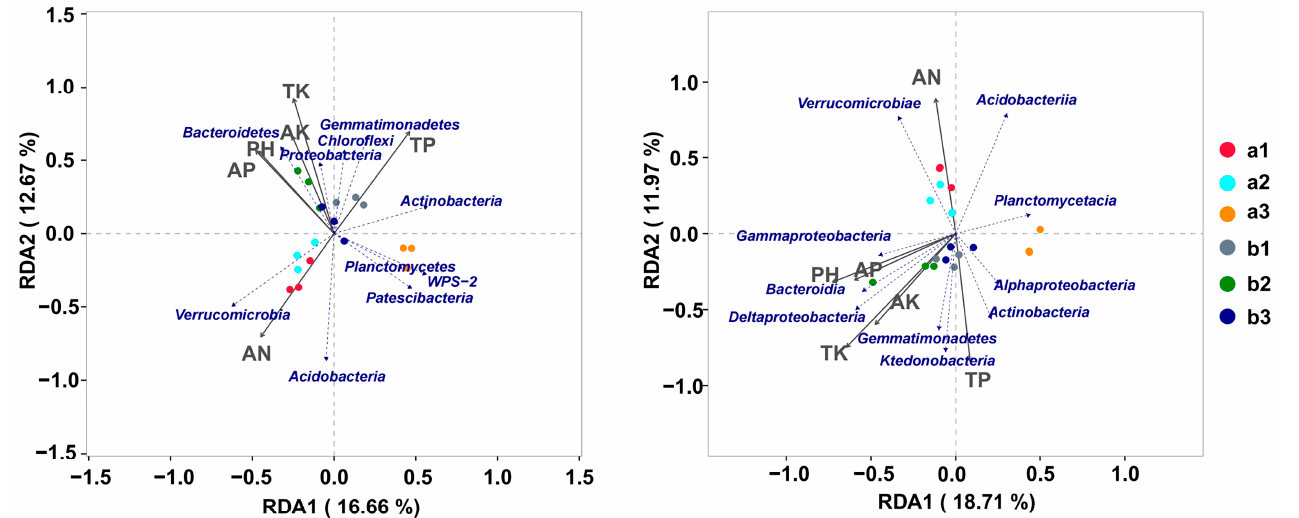
Figure 6. Ordination plots using redundancy analysis (RDA) were used to demonstrate the rela- tionship between bacterial communities and soil properties. The arrows indicate the lengths and angles between explanatory and response variables and reflect their correlations. Different samples are marked with different colors. a1, a2, and a3 represent the bulk soil of the three upslope sam- ple plots, respectively, and b1, b2, and b3 represent the bulk soil of the three downslope sample plots, respectively.